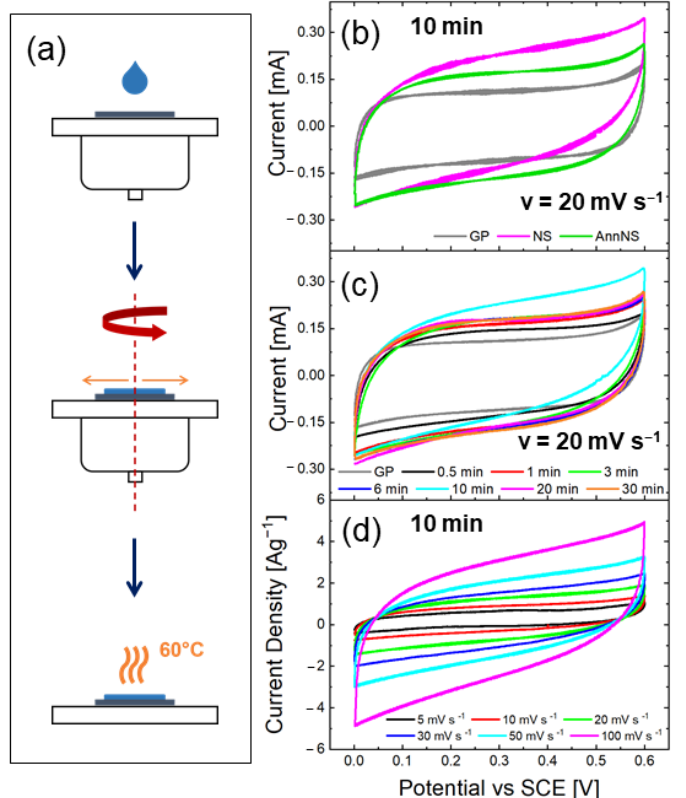
Figure 3. ( a ) Schematic of sample preparation for electrochemical characterization. CV curves in 1 M Na 2 SO 4 of GP substrate (grey line); nanostars as prepared (magenta line) and after annealing (green line) at 20 mV/s ( b ); CV curves in 1 M Na 2 SO 4 of NSs with 0.5, 1, 3, 6, 10, 20, and 30 min growth times and GP at 20 mV/s ( c ); CV curves in 1 M Na 2 SO 4 of as-prepared NS at different scan rates ( d ).